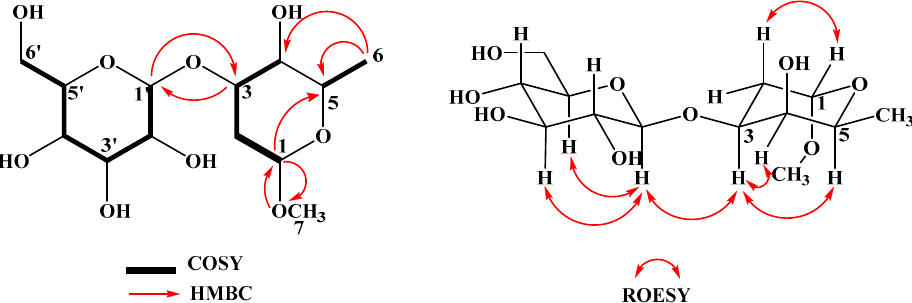
Figure 2. Selected 2D NMR correlations for 1-methoxy-3- O - β -glucopyranosyl- α - L -oliose ( 1 ).